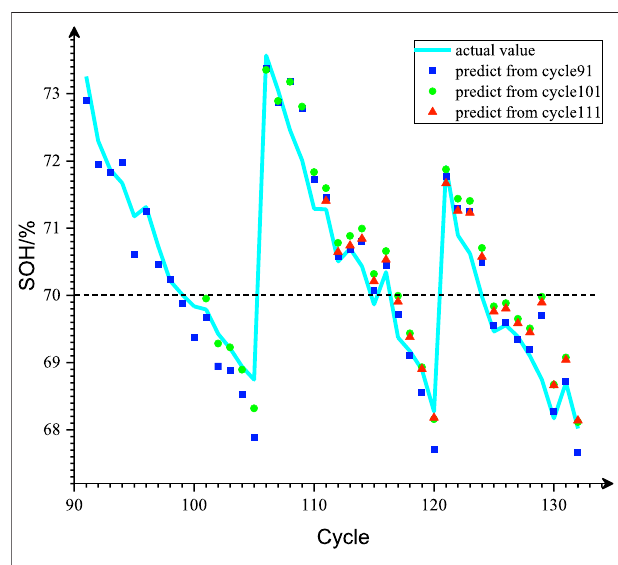
FIGURE 7 | B0018 SOH prediction effect under different prediction starting points (TCN).